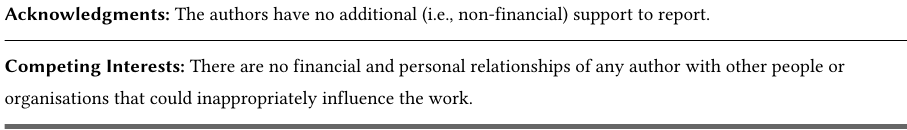
Table 1: Characteristics of the included studies Table 2: Variables, measurement methods and comparison groups of the included studies Index of Supplementary